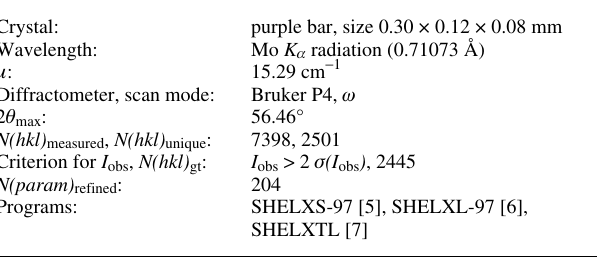
Table 1. Data collection and